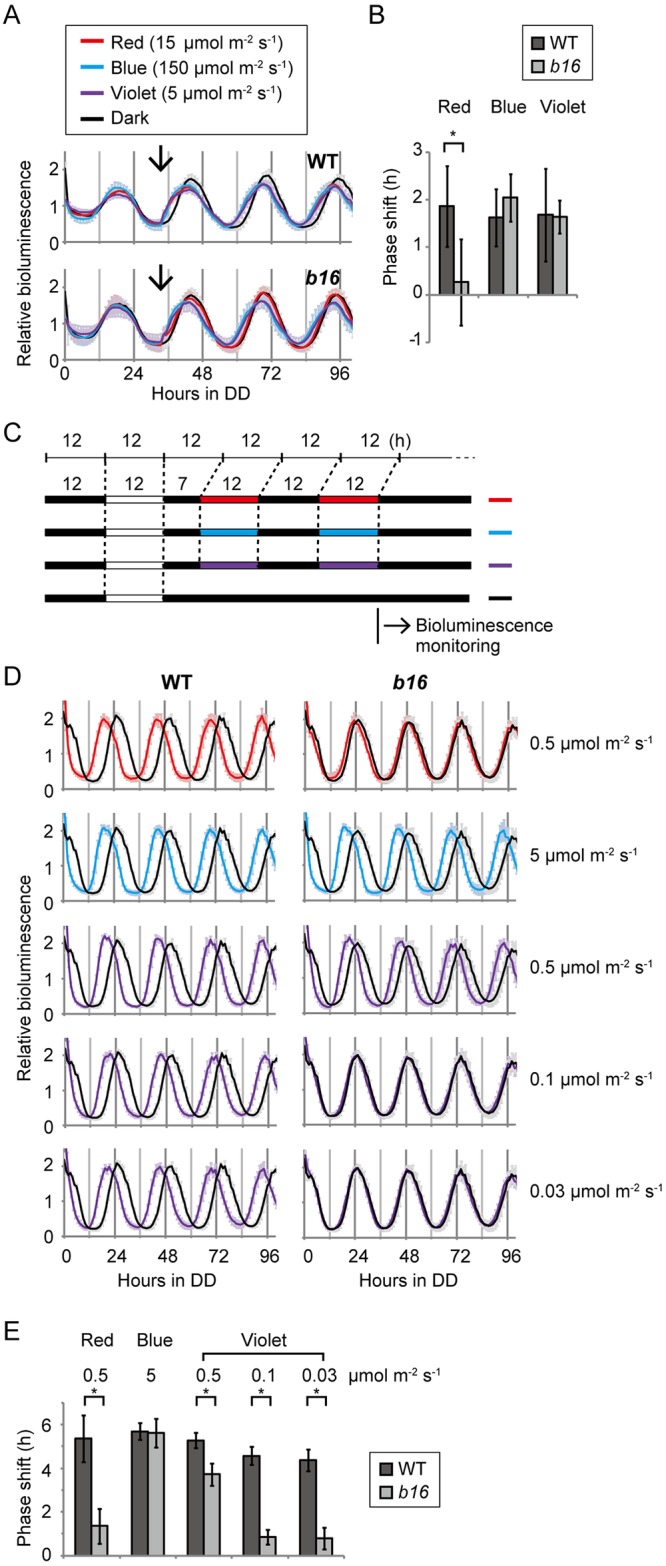
Phase resetting of the circadian clock in the b16 mutant.Bioluminescence rhythms of 5-day-old spot cultures of WT and b16 cells on HS agar media in white 96-well plates were measured. (A) Bioluminescence trace of a phase shifting experiment. Cells were exposed to a 12 h dark/12 h white light to entrain their circadian clock, and then bioluminescence rhythms were monitored in DD. 5 min light pulses were given at the 34 h time point in DD (arrows). Bioluminescence data are detrended by dividing by the 24 h moving average, and are shown as the mean ± SD of 10 independent cultures. (B) The amount of phase shift. Mean ± SD of the 10 independent cultures of the phase difference (h) between light-pulsed and dark control samples are shown. * P < 0.001 (Student’s t-test). (C) Schematic view of light conditions of the re-entrainment experiment. Cells were entrained by the first LD cycle of white light, and then re-entrained to a 5 h phase advanced LD cycles of red, blue, and violet light. Bioluminescence was monitored after release into DD. (D) Bioluminescence trace of re-entrainment experiment. Data are detrended by dividing by the 24 h moving average, and are shown as the mean ± SD of 10 independent cultures. (E) The amount of phase shift. The mean ± SD of 10 independent cultures of the phase difference (h) between light-entrained and dark control samples is shown. * P < 0.001 (Student’s t-test).